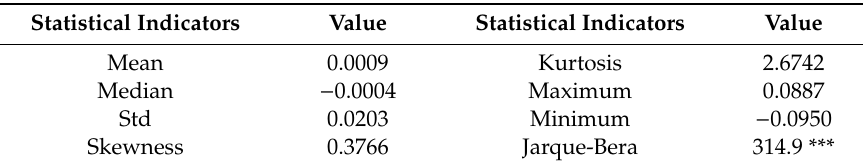
Table 1. Descriptive Statistics (971 Observations).